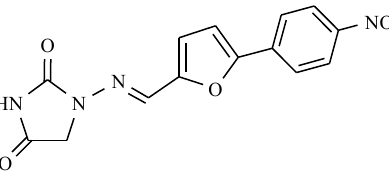
Figure 21. Figure 21. Dantrolene.